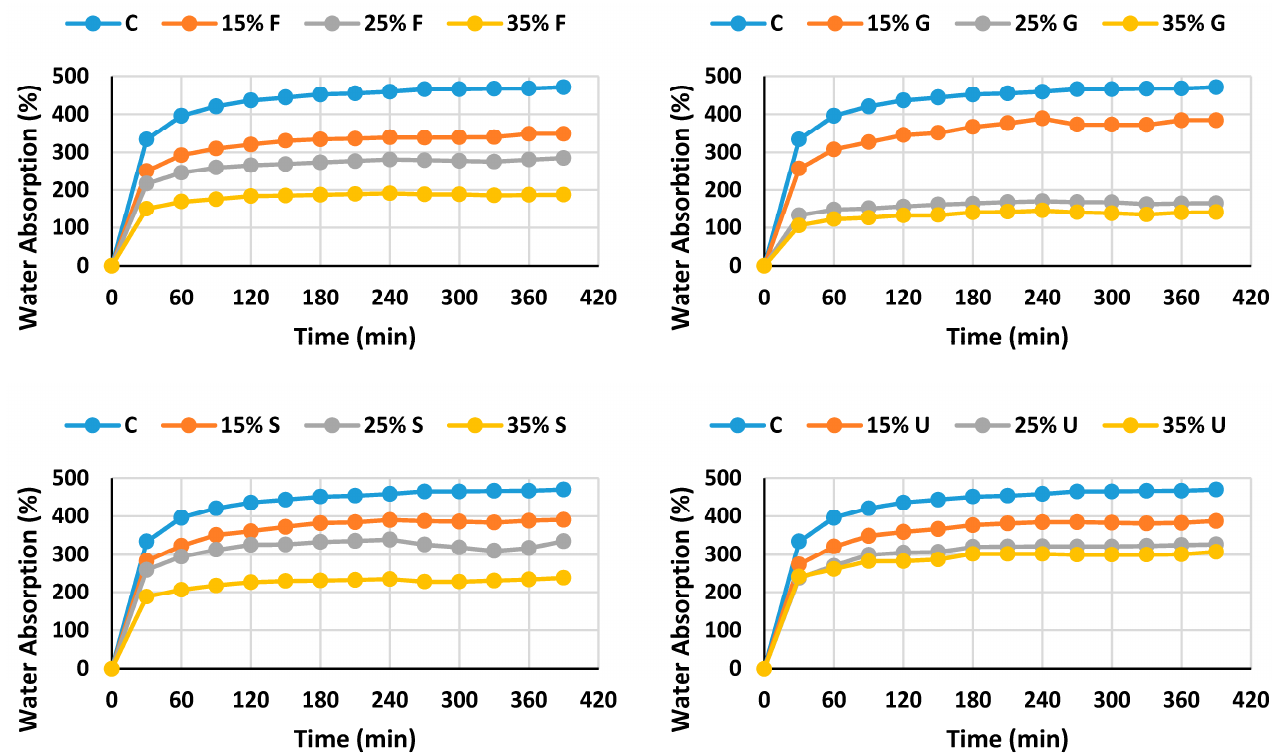
Figure 2. Water absorption of wheat starch-based films and various plasticizers.